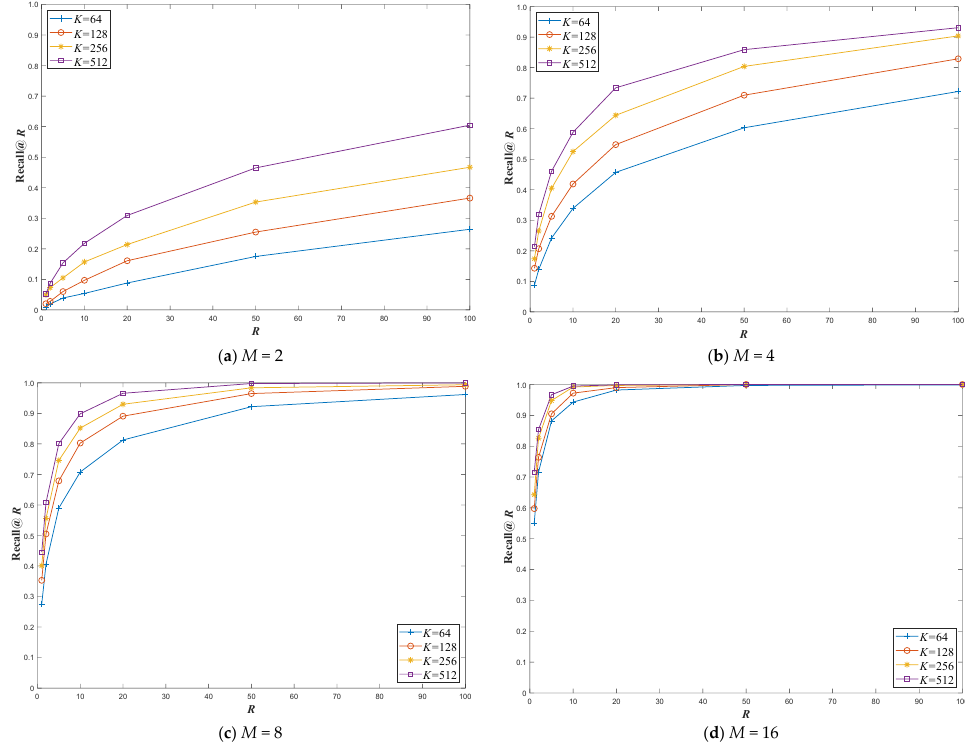
Figure 7. ANN Search accuracy under different K and M on SIFT-1M. Figure 7. ANN search accuracies under different K and M on